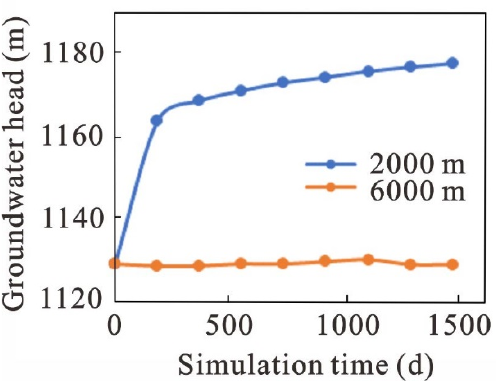
Figure 16. Variation in water level in borehole D54 for different water-storage ranges.